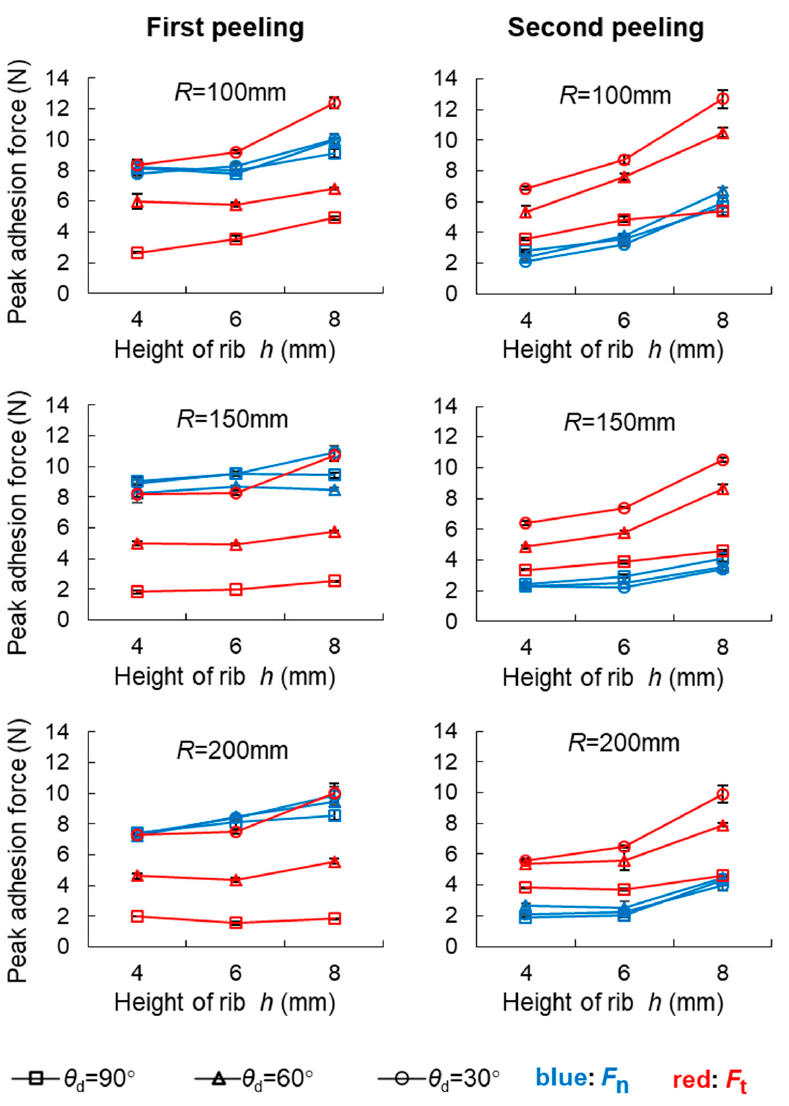
Figure 7. The peak forces of F t and F n in the first and second peelings of three SPAAs with different “rib” heights peeling off from cylinders with radii of 100 mm, 150 mm, 200 mm at peeling angles of 90°, 60°, 30°.